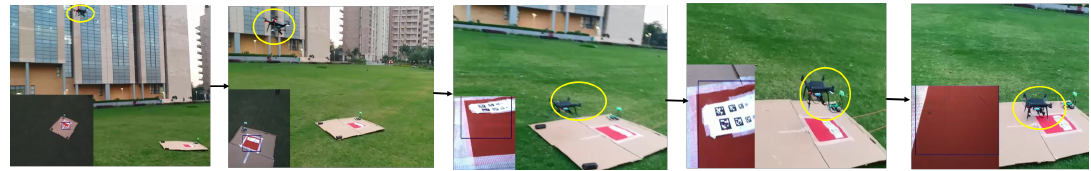
Figure 14. Landing sequence on a ground moving